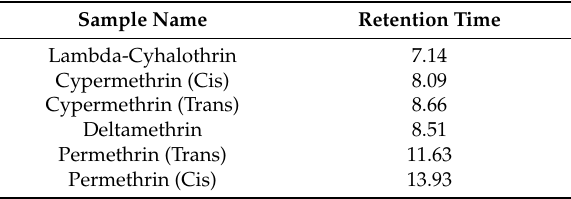
Table 3. Retention time of the main pesticide ingredients detected in soil.